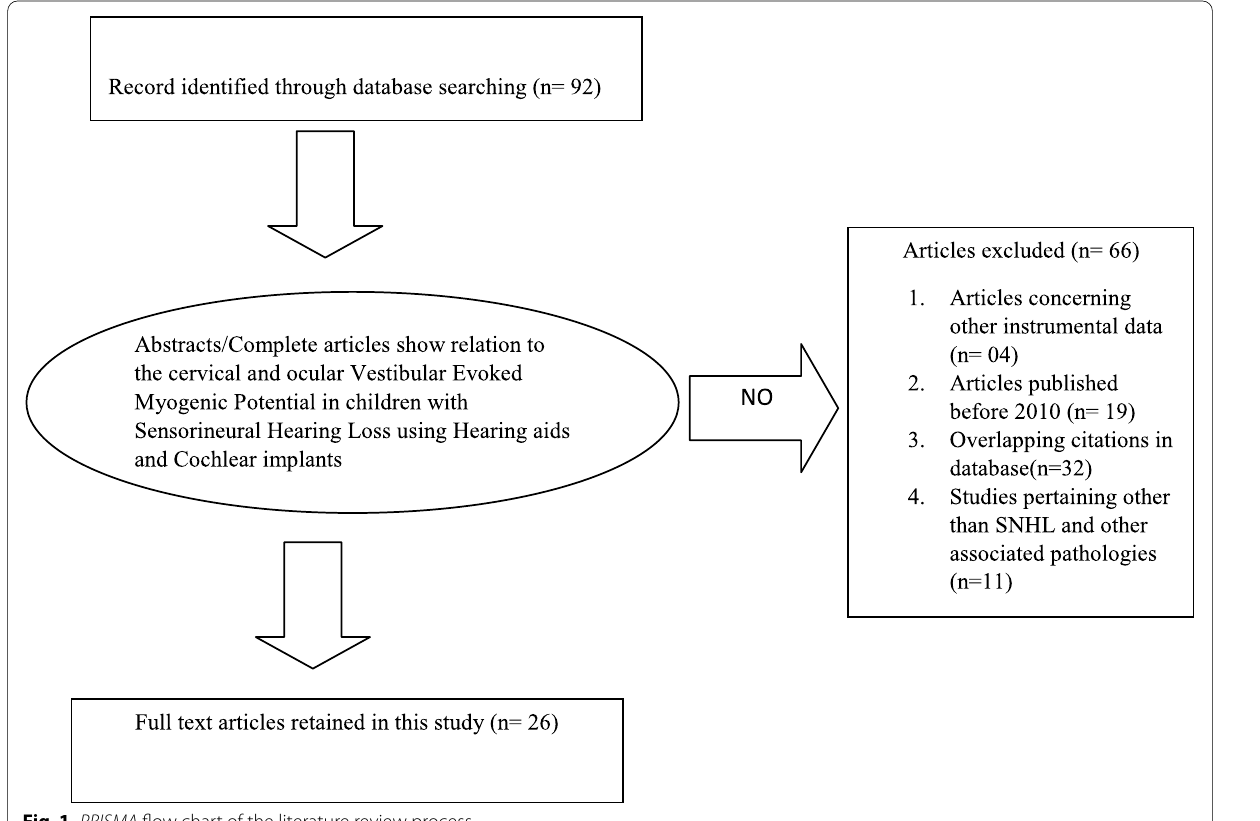
Fig. 1 PRISMA flow chart of the literature review